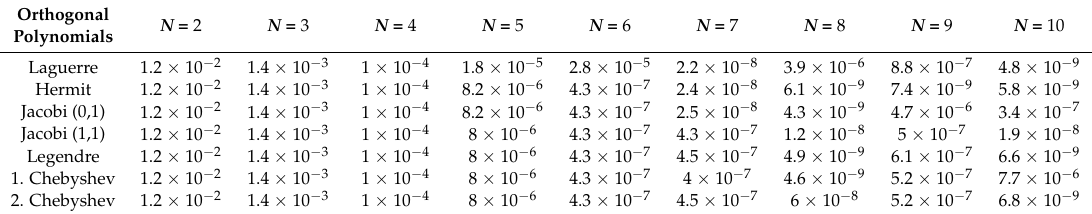
Table 3. Maximum error for Example 6 using the collocation point (b).